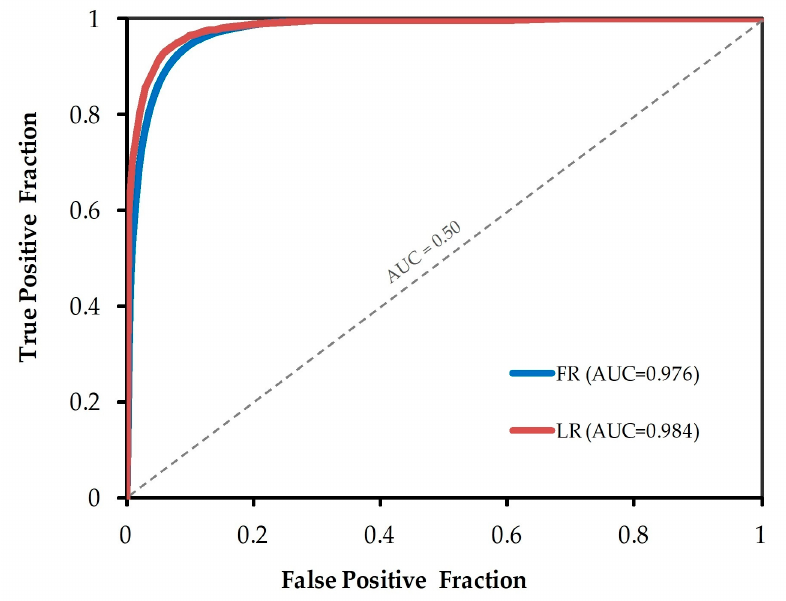
Figure 7. Receiver operating characteristics (ROC) curves of the models. Table 4 . ROC analysis results of the models.